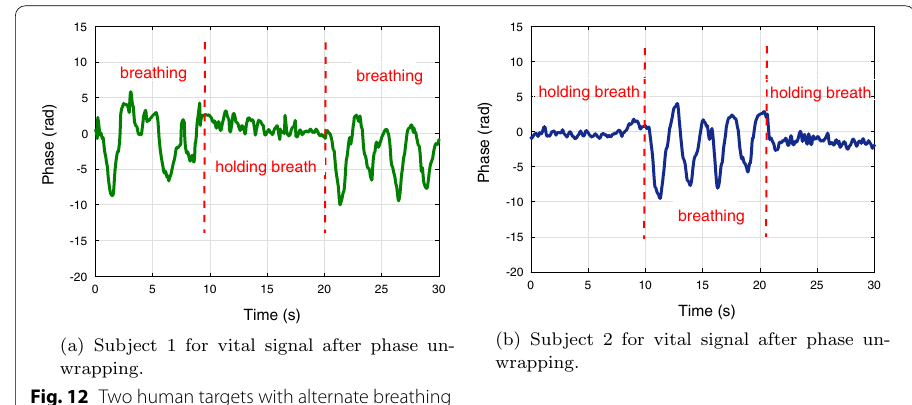
Fig. 12 Two human targets with alternate